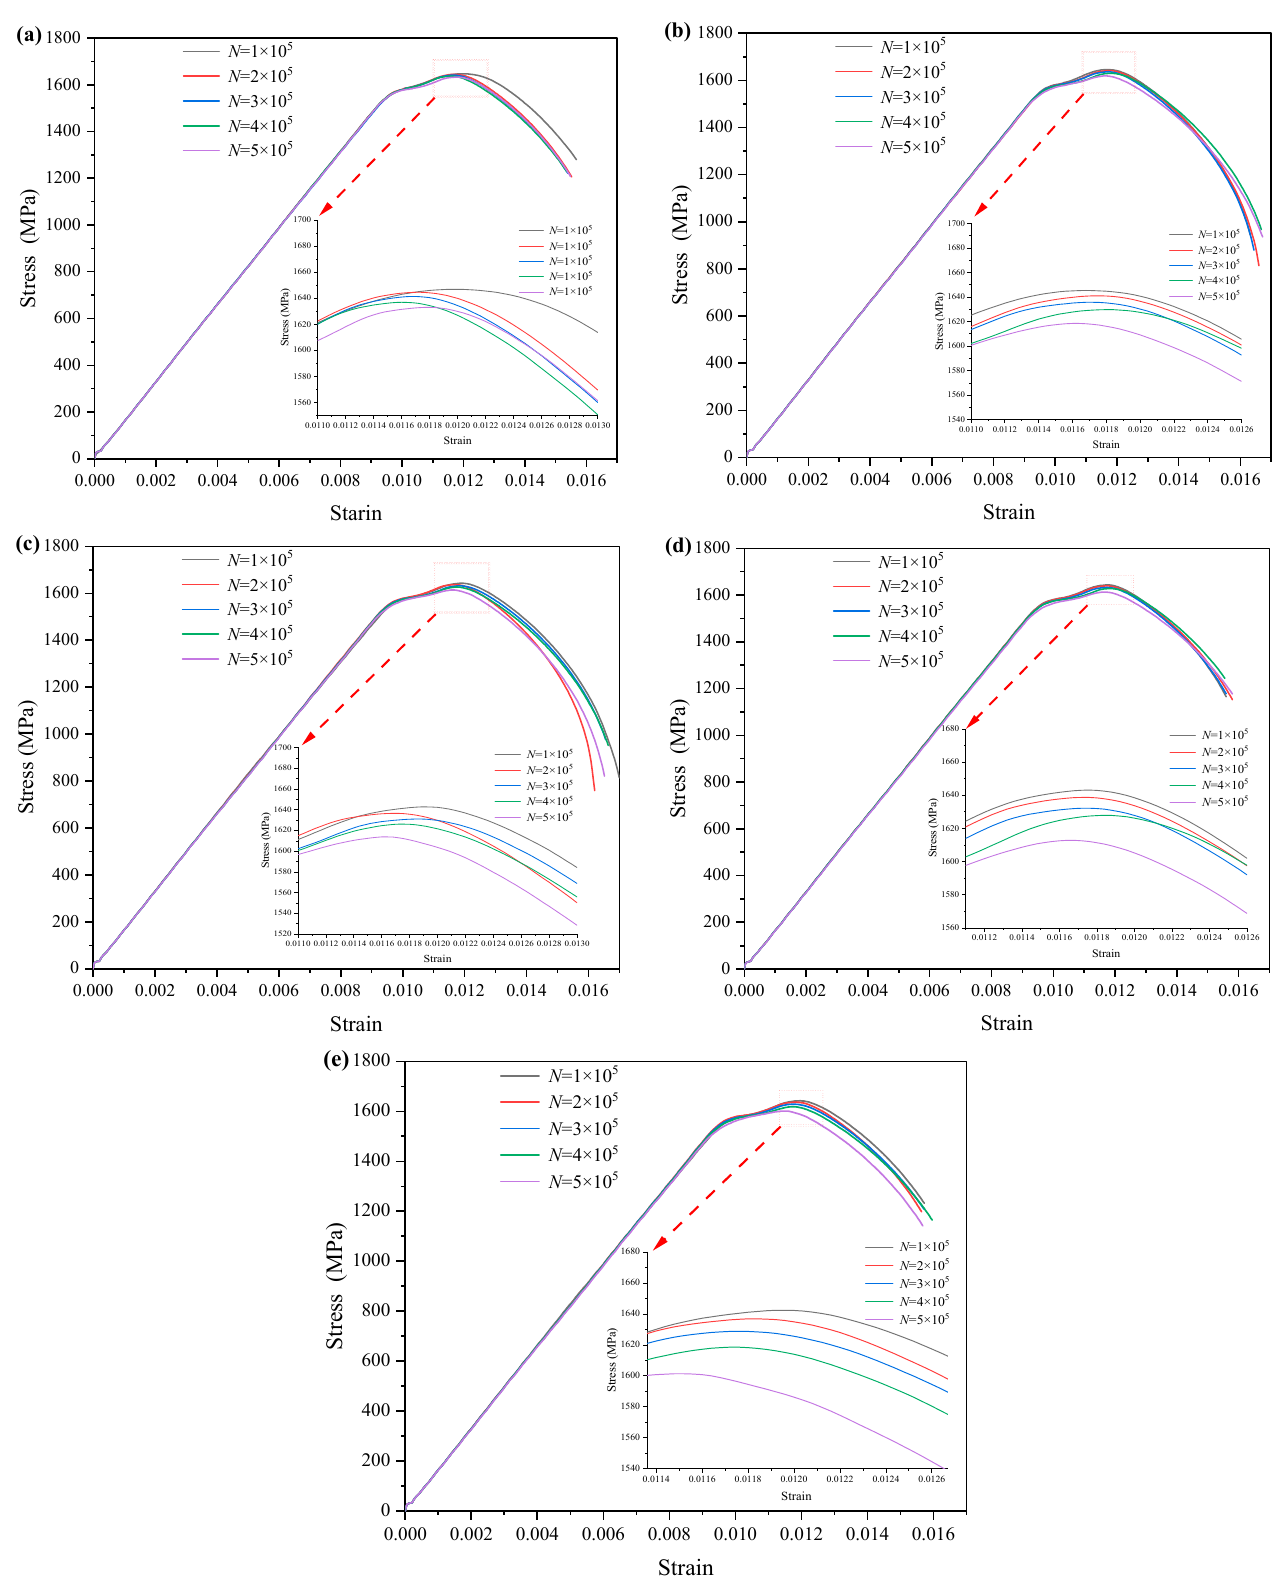
Figure 9. Simulated stress–strain curves of damaged wire and wire: ( a ) F n = 60 N and F max = 1000 N; ( b ) F n = 80 N; ( c ) F n = 100 N; ( d ) F max = 1100 N; ( e ) F max = 1200 N.